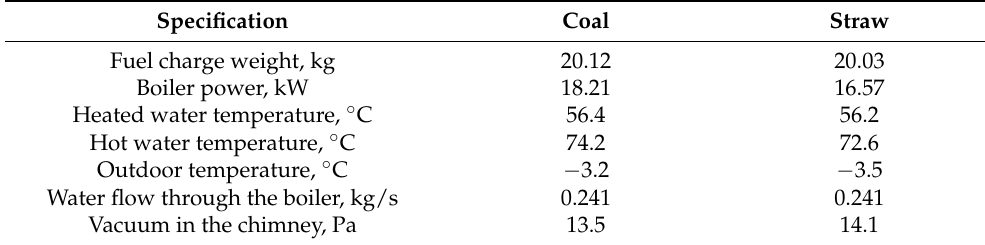
Table 1. Energy parameters of individual fuels and the boiler during measurement.